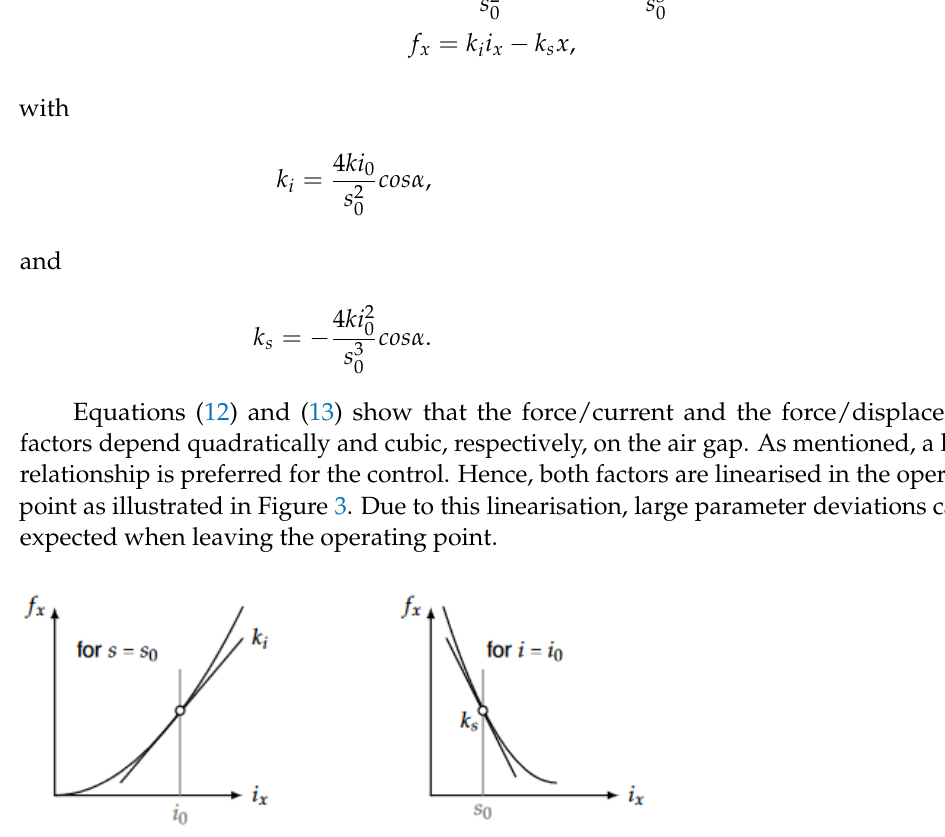
Figure 3. Linearised force-current factor k i and force-displacement factor k s ; adopted from